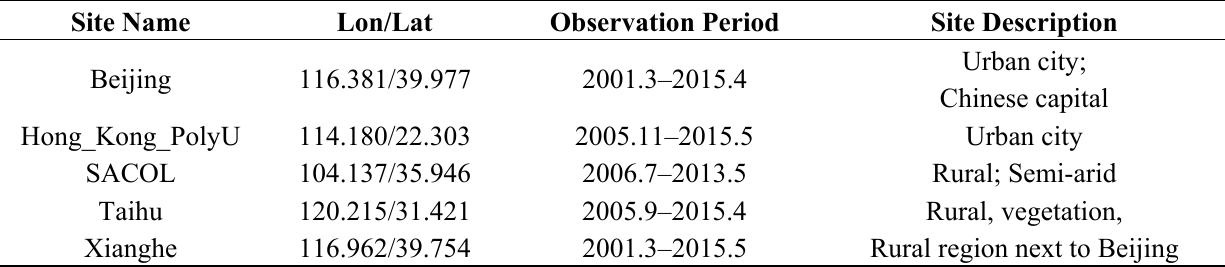
Table 1. The location of the five AERONET sites over